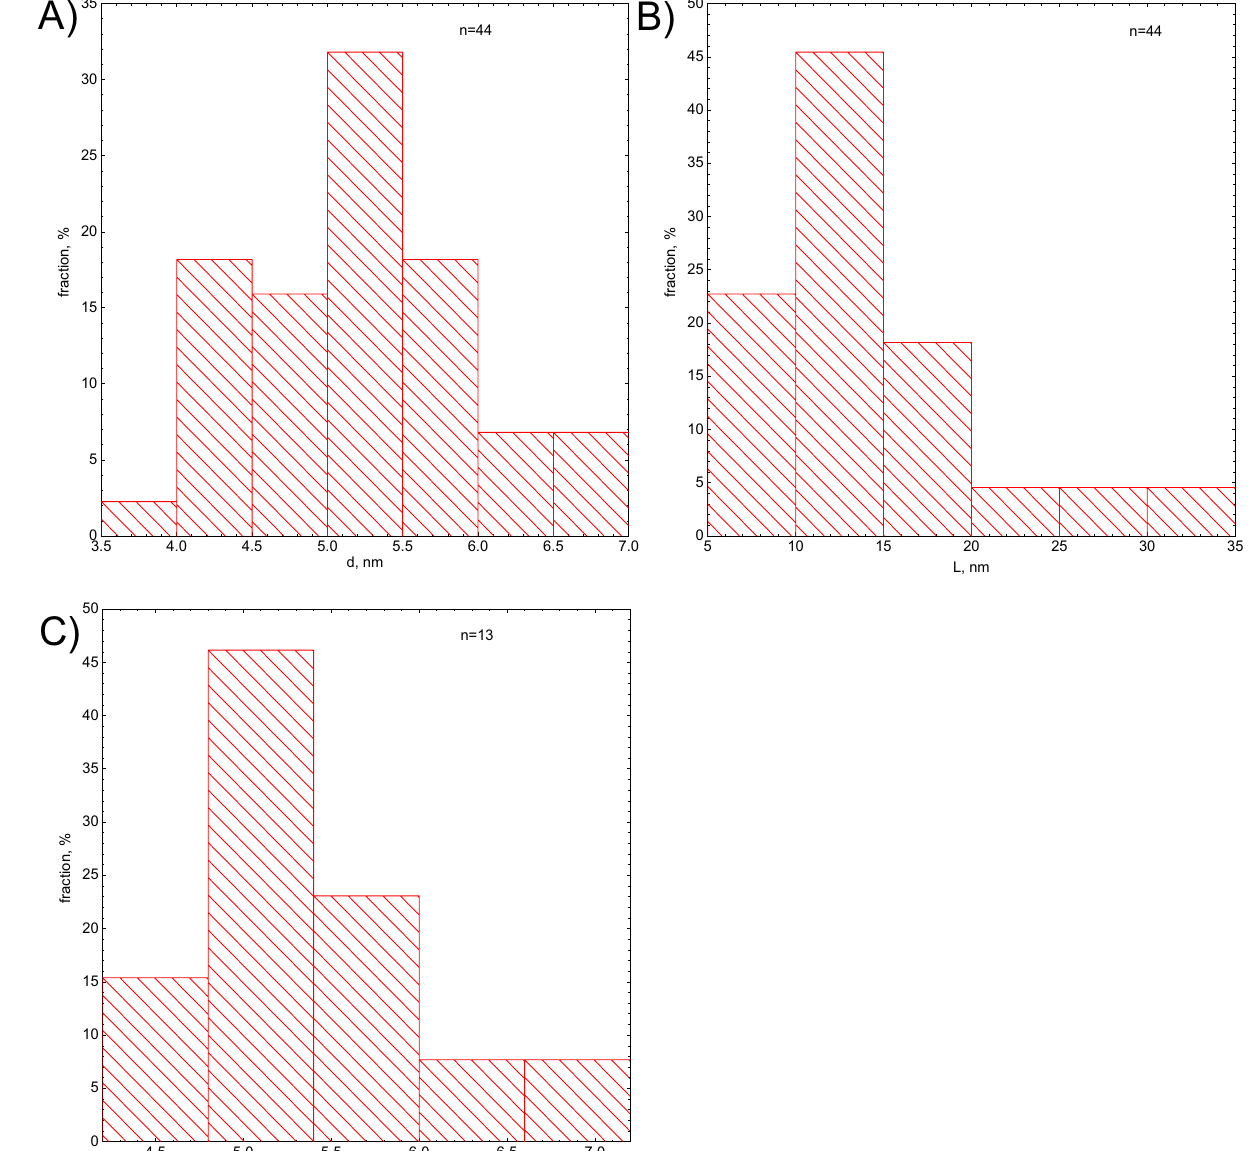
Figure 8. Size distribution determined from HR-TEM, ( A , B ) for elongated nanoparticles, ( C ) for spherical